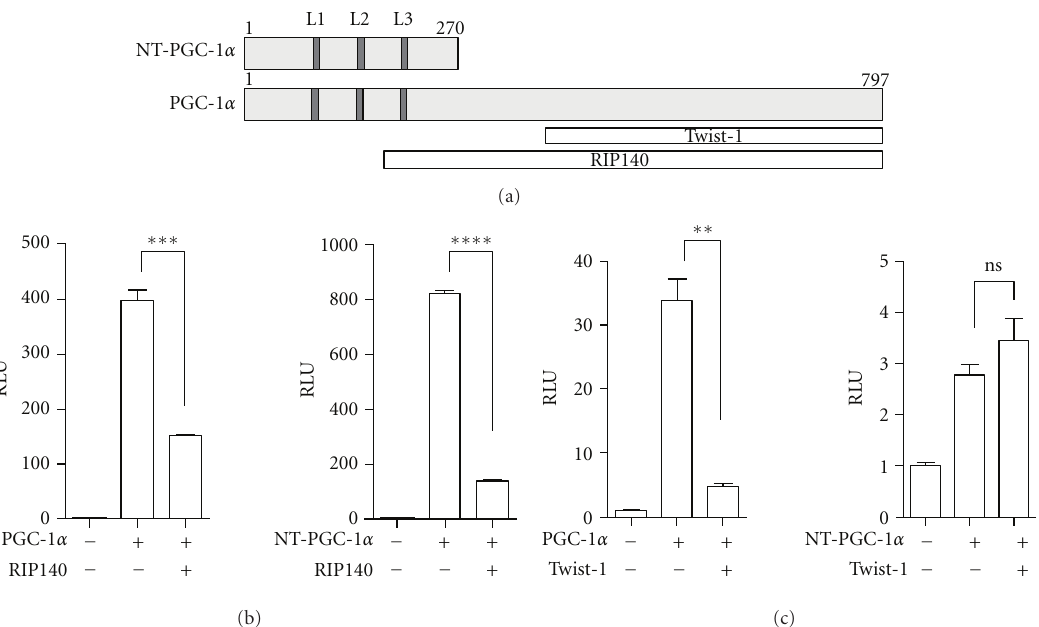
Figure 1: E ff ects of transcriptional regulators on PGC-1 α and NT-PGC-1 α function. (a) Schematic diagram of PGC-1 α and NT-PGC-1 α proteins. L1, L2, and L3 represent leucine-rich motifs, one of which (L2) bears the conserved LXXLL sequence that interacts with nuclear receptors. Two white boxes represent the interaction regions of PGC-1 α with transcriptional regulators, Twist-1, and RIP140, respectively. (b), (c) Transcriptional repression assay using a luciferase reporter. pcDNA3.1, PGC-1 α , and NT-PGC-1 α were cotransfected in COS-1 cells with Gal4-ERR α -LBD and RIP140 (b) or PPAR γ and Twist-1 (c). Luciferase activity was determined 48 h after transfection and the relative luciferase units were calculated as described in Materials and Methods. Data represent mean ± SEM of at least three independent experiments. Significant di ff erence is determined by student t -test ( ∗∗ P < 0 . 01; ∗∗∗ P < 0 . 001; ∗∗∗∗ P < 0 . 0001; ns: not significant).